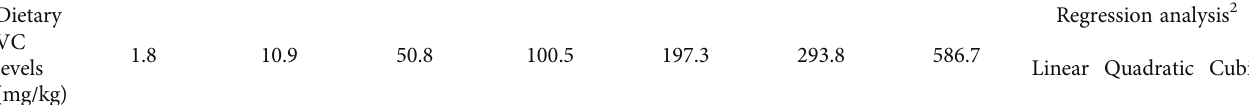
Table 5: Serum and hepatic antioxidative enzyme activities in coho salmon Oncorhynchus kisutch (Walbaum, 1792) postsmolts fed the experimental diets with graded vitamin C (VC) levels after 10 weeks 1